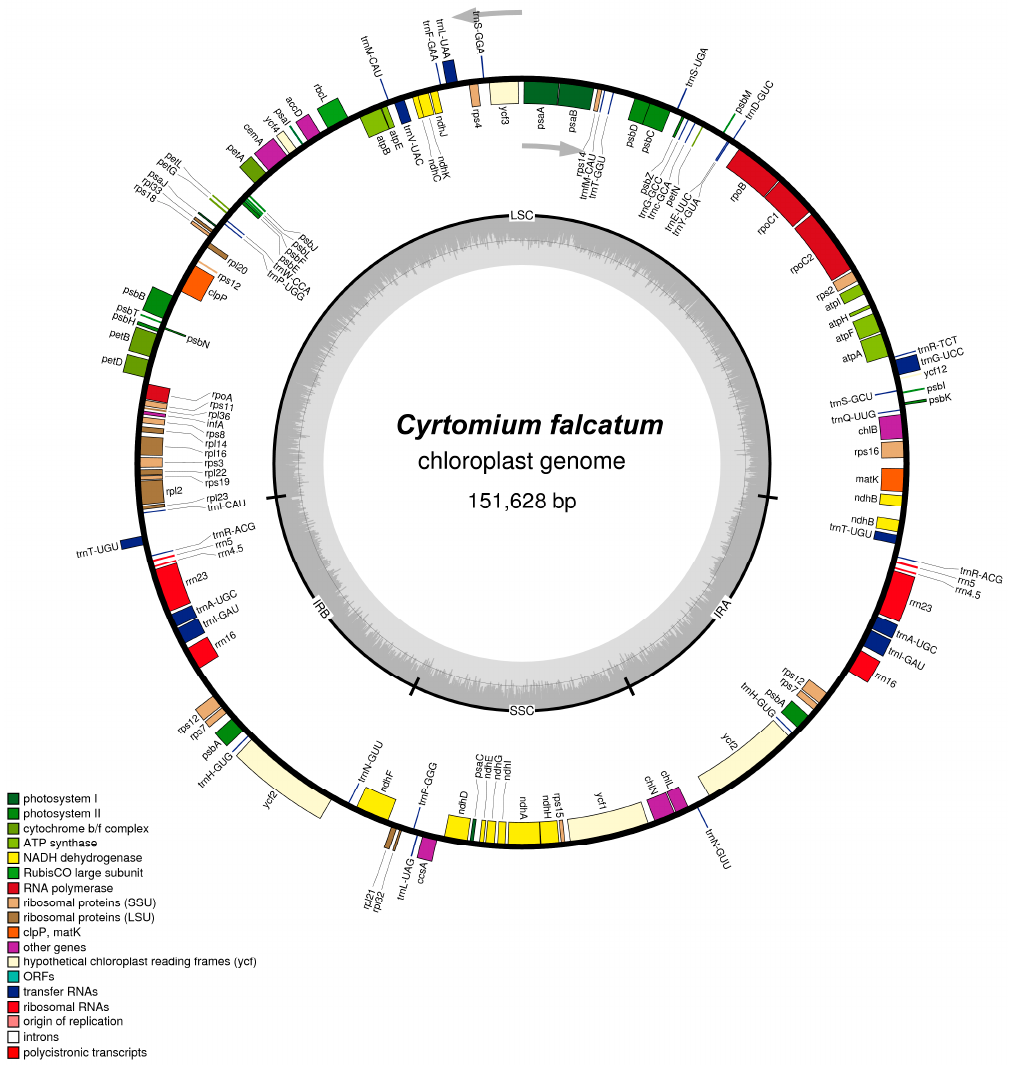
Figure 1. Gene map of Cyrtomium falcatum . Genes located on the outside of the outermost layer of the circle are transcribed in a counterclockwise direction, whereas genes located on the inside of the circle are transcribed in a clockwise direction. The colored bars indicate known protein-coding genes, transfer RNA (tRNA) genes and ribosomal RNA (rRNA) genes. The dashed, darker gray area in the inner circle denotes the guanine-cytosine (GC) content of the genome, whereas the lighter gray area indicates the adenosine-thymine (AT) content of the genome. Abbreviations annotated along the perimeter of the inner circle are translated as follows: LSC, large single copy; SSC, small single copy; IR, inverted repeat.